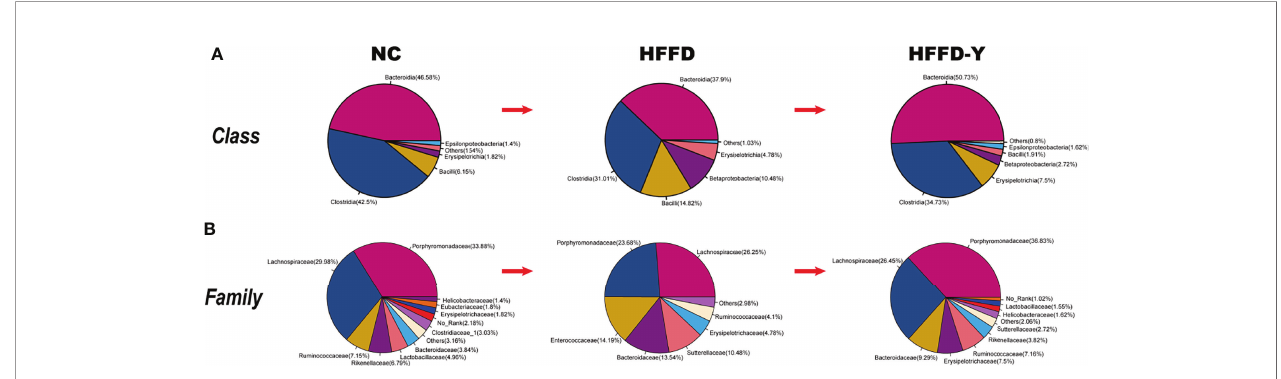
FIGURE 3 | Gut microbiota proportion and variations. (A) Analysis results at the class level. (B) Analysis results at the family